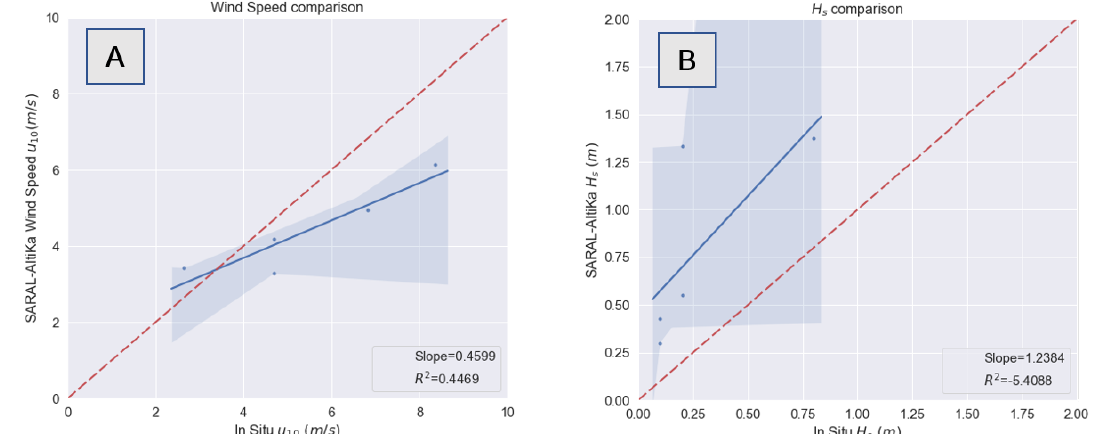
Figure 5. Comparison of u 10 ( A ) and H s ( B ) between SARAL/AltiKa and buoy station 44040. Matched measurements denoted as blue dots are those falling within radius R p 25 . The fitting linear regression line is shown as a continuous blue line with their corresponding 99% confidence interval in shaded blue. In this case, the sample size is too small. The large discrepancy of the regression line with respect to the diagonal is mostly attributed to land data